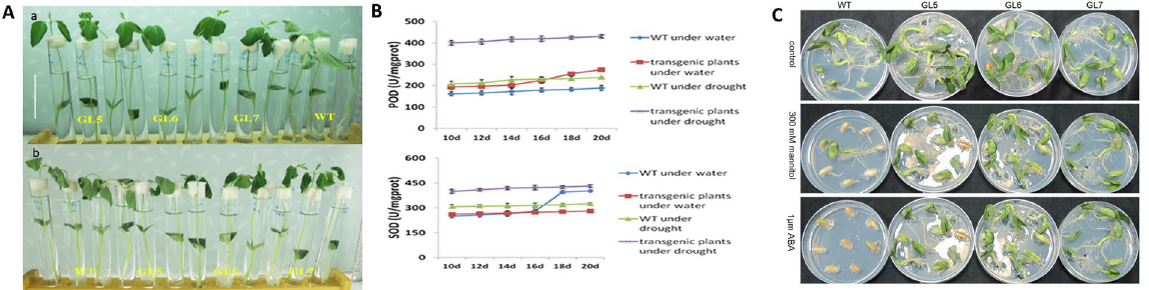
Figure 6. ( A ) The phenotype of GmSYP24ox and wild type soybean seedlings into the solution including 300 mM NaCl for 36 h or 25% PEG for 12 h. Bar = 5 cm. ( B ) Measurement of POD and SOD content in transgenic and wild type plants. ( C ) The germination of GmSYP24 ox and wild type soybean seeds under ABA or mannitol